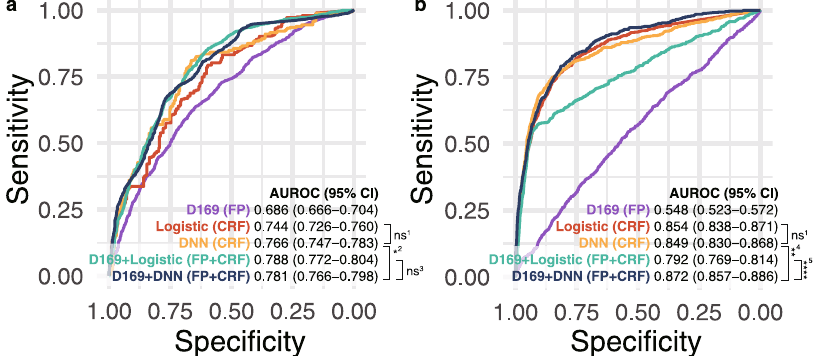
Fig. 2 Prediction performance of the models. Receiver operating characteristic curves in the internal validation set ( a ) and external validation set ( b ). The performances of the models (Models 1 – 5) are described in Table 2. 1 The differences in AUROCs between the logistic regression and the DNN are not signi fi cant ( p -value = 0.079 in a and p -value = 0.531 in b ). 2 The difference in AUROCs between the DNN and the multimodal network is marginally signi fi cant ( p -value = 0.047). 3 The difference in AUROCs between the ensemble model (D169 + logistic regression) and the multimodal network is not signi fi cant ( p -value = 0.541). 4 The difference in AUROCs between the DNN and the multimodal network is signi fi cant ( p -value = 0.004). 5 The difference in AUROCs between the ensemble model (D169 + logistic regression) and the multimodal network is signi fi cant ( p -value < 2 × 10 − 16 ). AUROC area under the receiver operating characteristic curve, CI con fi dence interval, D169 DenseNet-169, FP fundus photographs, Logistic logistic regression, CRF clinical risk factors, CRF, DNN deep neural